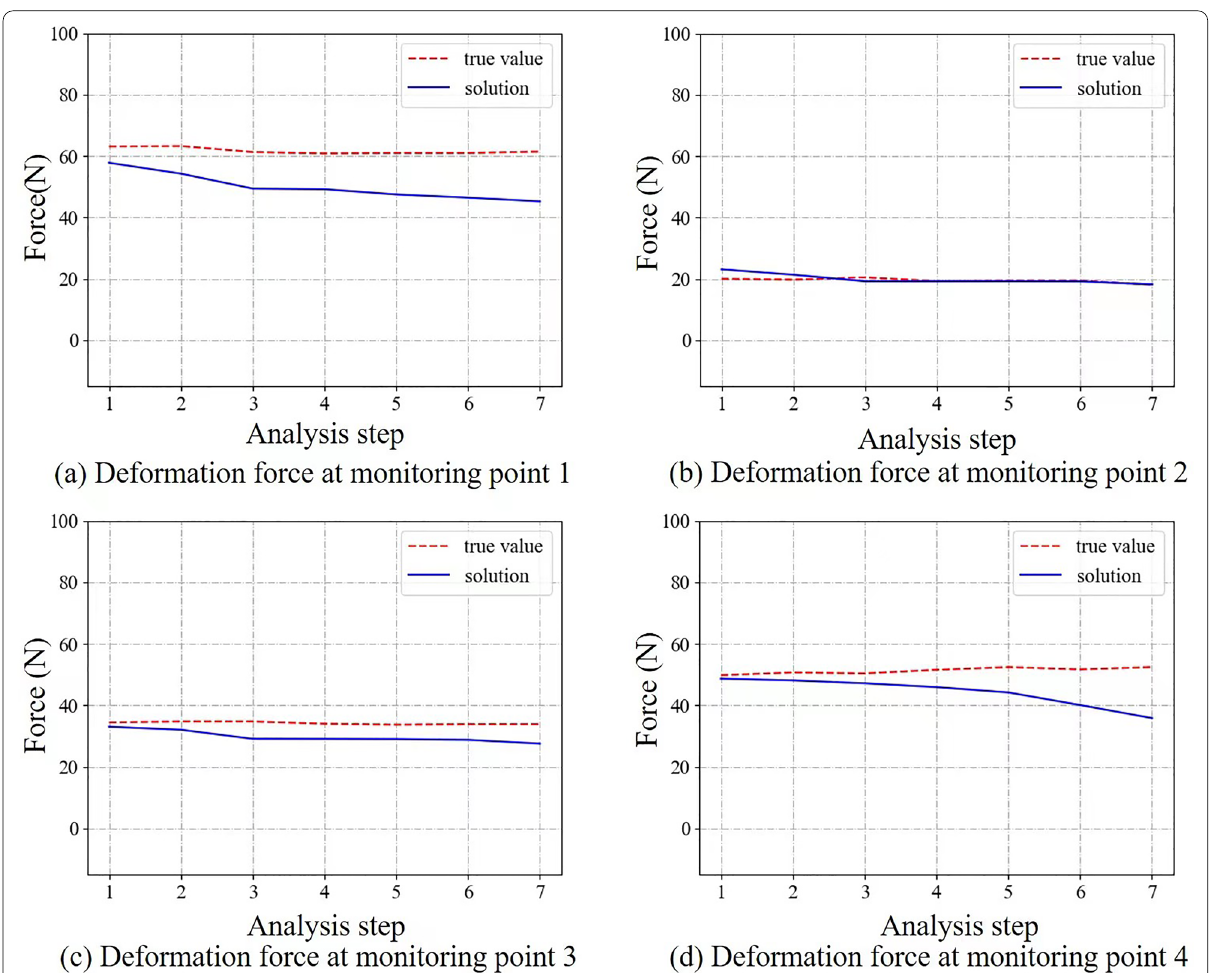
Figure 15 The solved deformation force and compared with real monitored deformation force for the milling depth of 23 mm